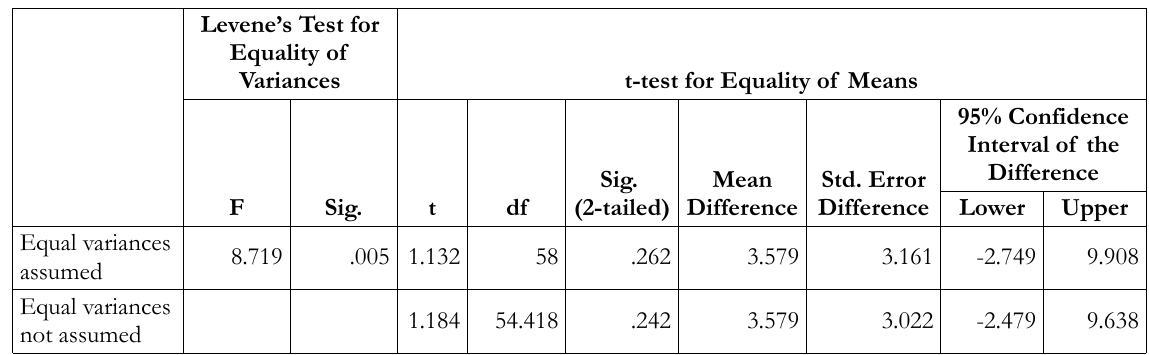
Table 7. T-test result of critical thinking skills of chemistry education